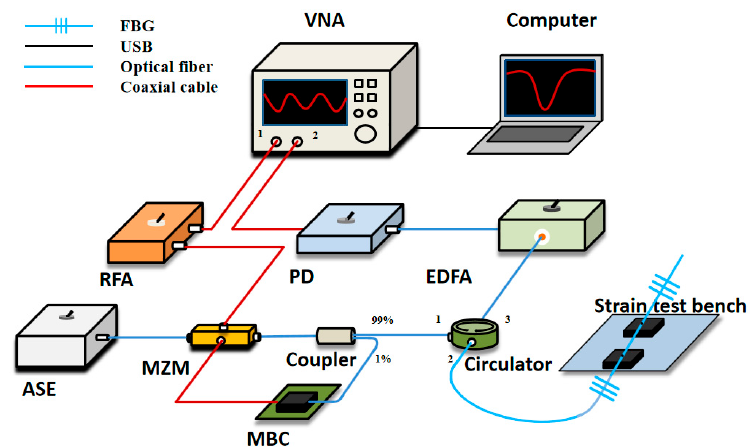
Figure 1. Schematic of the optical carrier-based microwave interferometry (OCMI) system configuration for concept demonstration. VNA: vector network analyzer. ASE: amplified spontaneous emission light source. MZM: Mach-Zehnder modulator. RFA: radio frequency amplifier. MBC: MZM’s bias controller. EDFA: erbium-doped fiber amplifier. PD: high-speed photodetector.